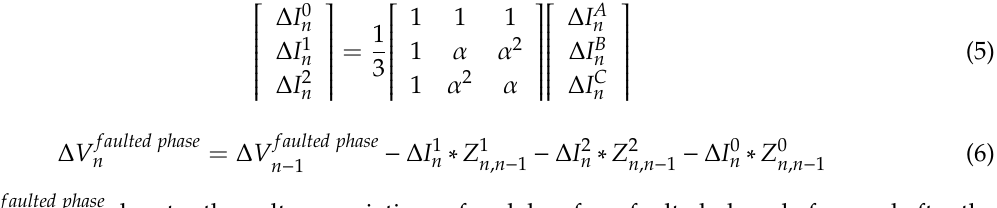
n − 1th bus. Figure 4 shows the flowchart of Stage 1 considering the above